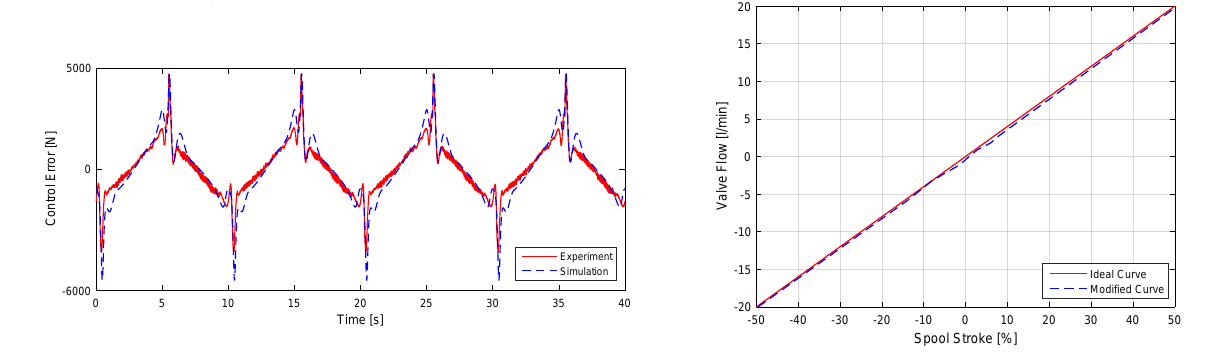
Figure 9: Variable gain characteristics introduced.